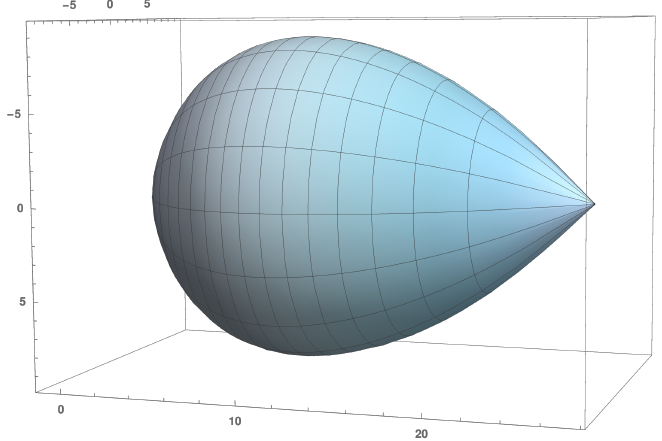
Figure 2 . Embedding diagram of the horizon of the black hole (5.2) for ∆ = 86 and K = 10